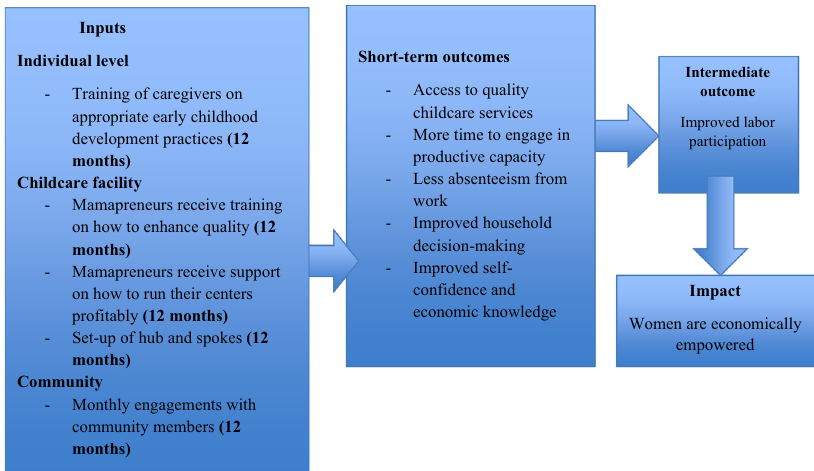
Fig. 1 Theory of change illustrating pathways to women's